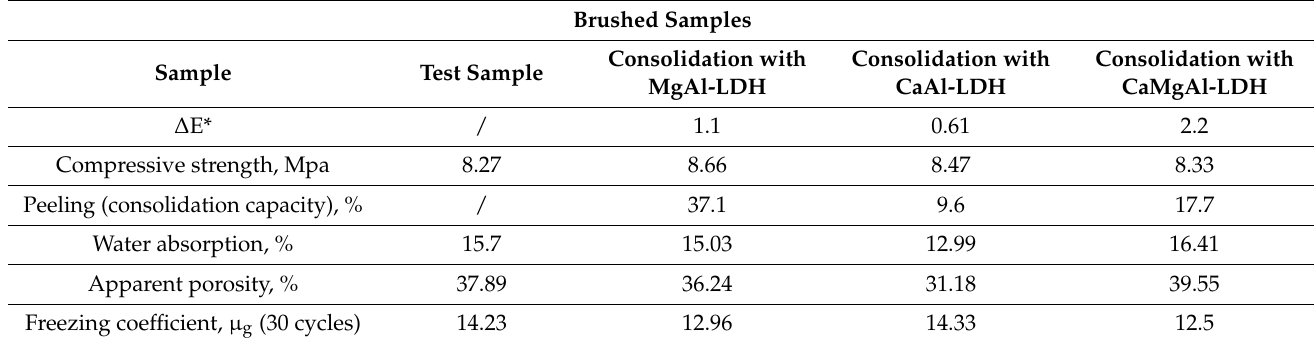
Table 5. The effect of consolidants applied by brushing over the brick samples’